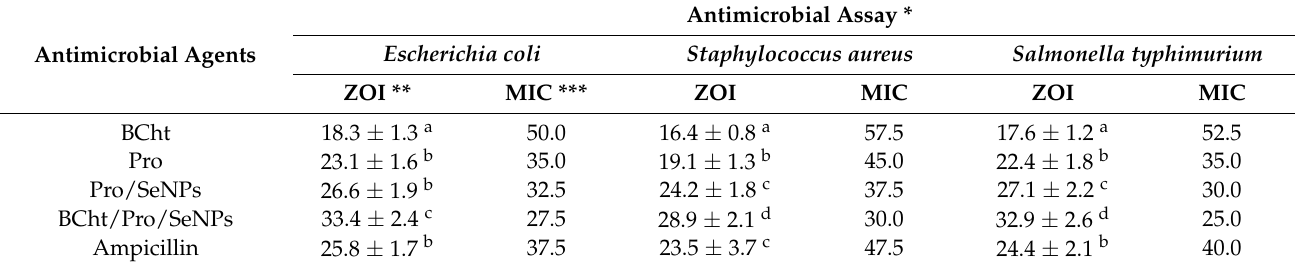
Table 2. Antimicrobial activity of bee chitosan nanoparticles (BCht), propolis (Pro), Pro/SeNPs and